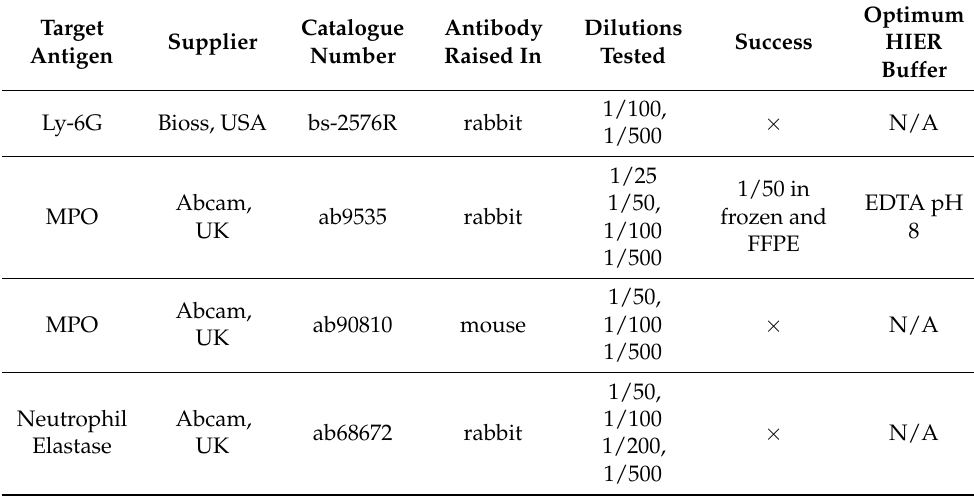
Table 1. Neutrophil-specific antibodies tested in rat tissue.